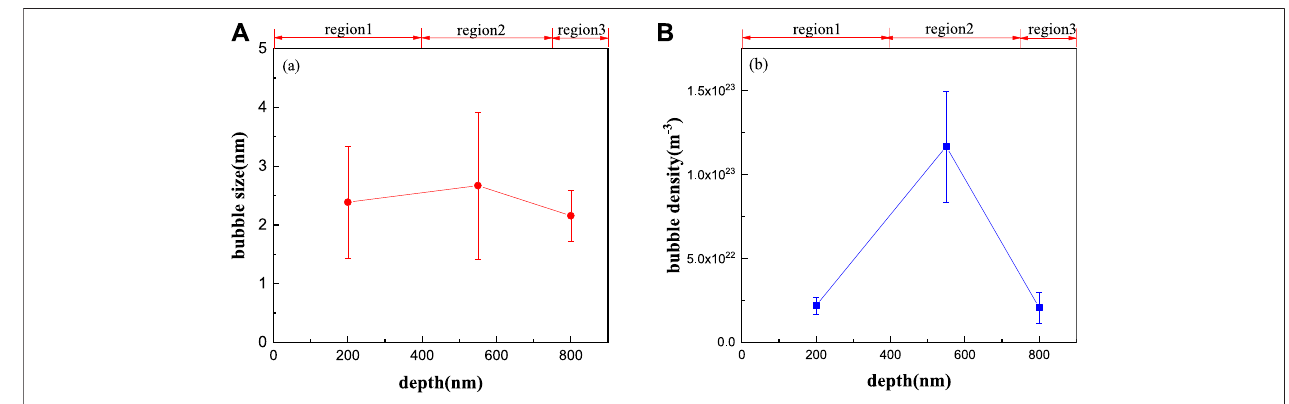
FIGURE 4 | (A) The average size of bubbles in different depth ranges and (B) the average density of bubbles in different depth ranges.